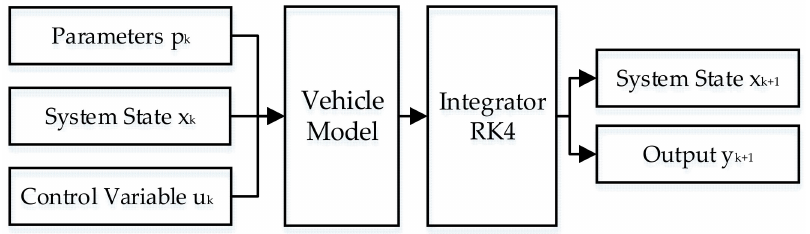
Figure 7. Illustration of the status update process.